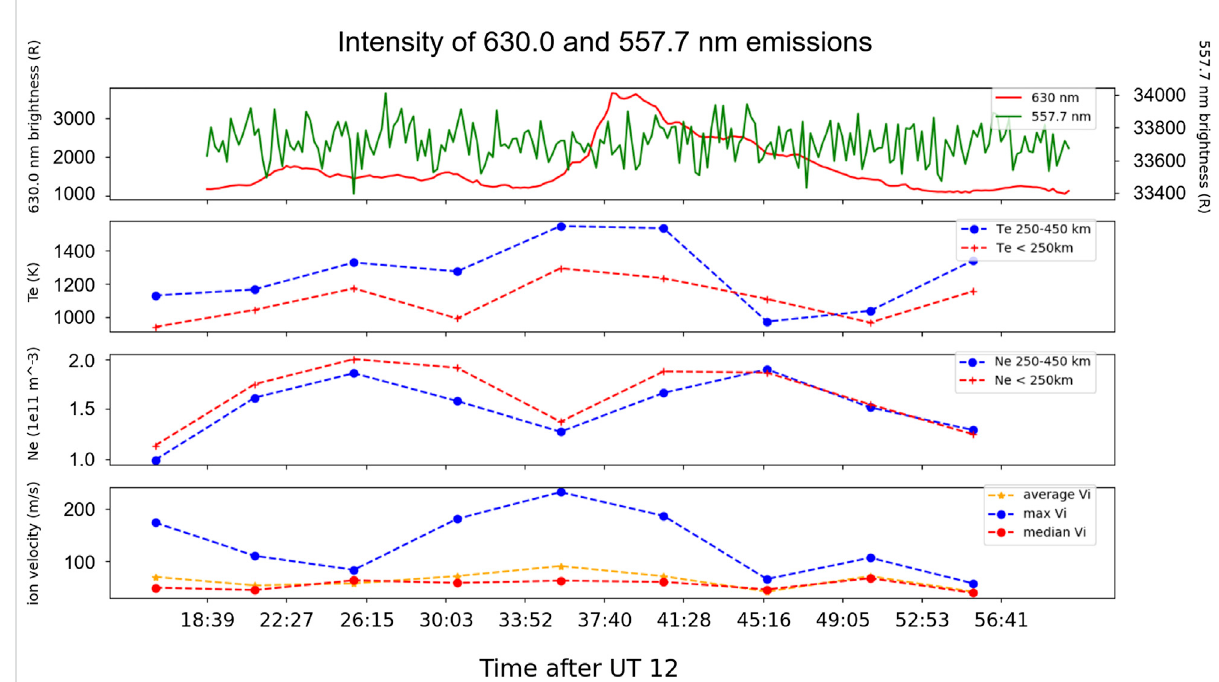
FIGURE 5 Intensity of the 630.0 (red-line) and 557.7 nm (green-line) emission shown together with their respective scales ( fi rst panel). The camera pixels used for this time series are an average of the 50 × 50 pixel square indicated in Figure 4. Parameters from PFISR Beam 7 are displayed in the subsequent panels for comparison. In each of these panels, the data has been averaged over altitude for each time interval. Electron temperature is shown inthesecondpanel, withtheblueline displaying theaveragebetween250and450 km andthered-line theaverage below250 km.The third panel shows the same averages for the electron density. The bottom panel shows the ion up fl ow velocities represented three ways: the maximum value (blue line) the average value (yellow line) and the median value (red line) all within the region between 250 and 450